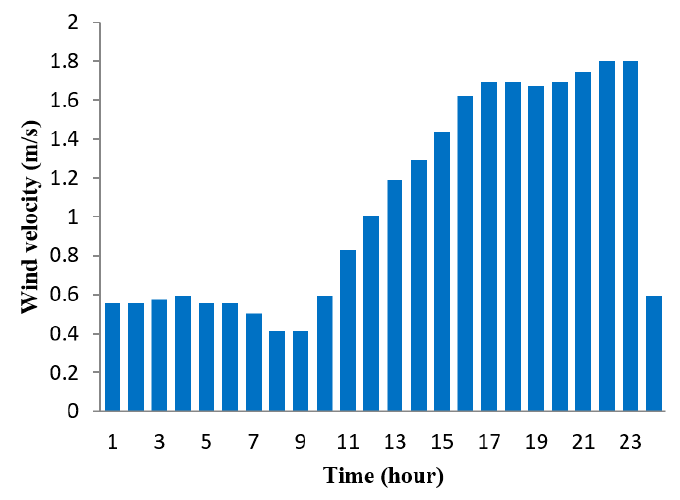
Figure 4. Predicted wind velocity over a 24 h horizon.